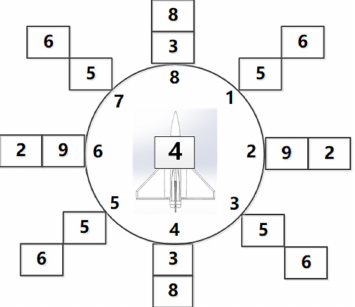
Figure 14. Reference for UAV at square